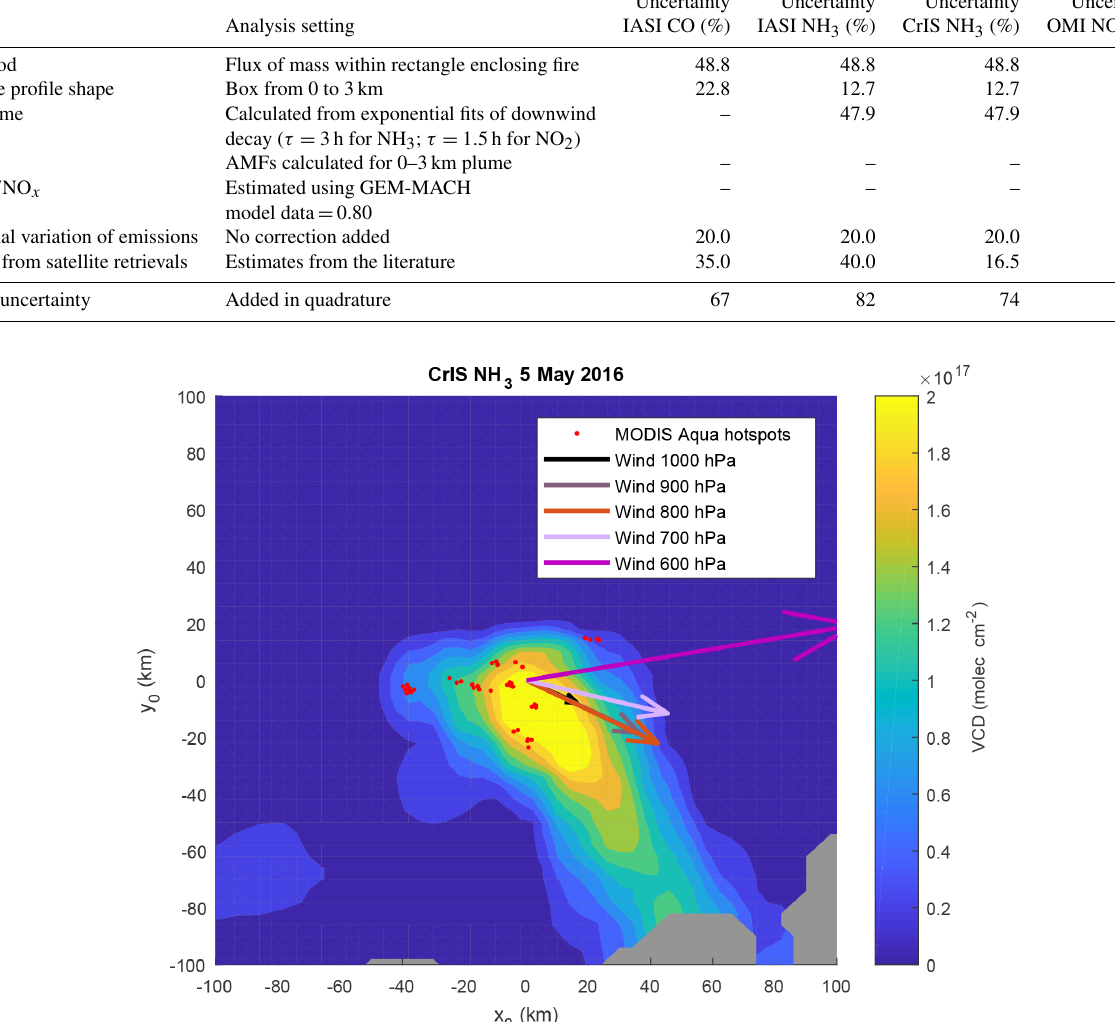
Figure 2. Gridded CrIS NH 3 VCDs on 5 May 2016, with MODIS Aqua fire hotspots (red dots) and ERA5 wind directions at various altitudes (arrows). Note that VCD data are presented in an unrotated frame of